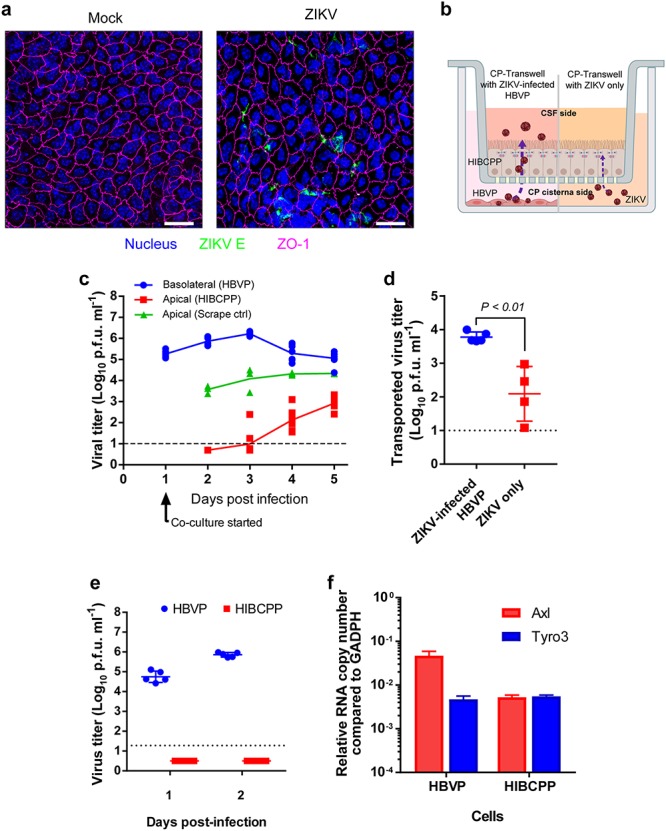
ZIKV crosses CP epithelial cell barriers.a, CPs isolated from ZIKV-infected mice were subjected to immunostaining in a whole-mount choroid plexus assay with antibodies against ZO-1 and ZIKV-E. The top and stroma cell layer was imaged with a Zeiss LSM 710 Duo/LIVE 5 confocal microscope along the Z-axis, and the maximum Z-project image was created with Imaris software. b, HIBCPP Transwell model. HIBCPP cells were grown and differentiated into a monolayer in Transwell inserts. Fully developed HIBCPP Transwell inserts (determined by TEER) were placed in wells with various testing conditions (e.g., primary human brain pericytes or conditioned media). c. Fully developed HIBCPP barriers grown in Transwell inserts (n = 3–5 per group) were basolaterally exposed to ZIKV-infected HBVP cells (starting at 1 DPI). As a leakage control, a scratch was made on the HIBCPP cells fully grown in Transwell inserts. Samples from the apical and basolateral chambers were harvested every 24 hours, and the virus titers were determined. d, Fully developed HIBCPP barriers grown in Transwell inserts (n = 4–5 per group) were basolaterally exposed to ZIKV-infected HBVP cells (3 d.p.i) or fresh media spiked with ZIKV (1.0 x 105 pfu/well/mL). Twenty-four hours later, the cell supernatant in the apical camber was harvested and the virus amount was enumerated. e, HBVP (blue circles) and HIBCPP (red squares) cells grown on 12-well plates were infected with ZIKV (m.o.i. = 0.1) and then incubated for two days. The virus titers in the supernatants were enumerated with a virus titration assay. f, Expression of Axl and Tyro3 in HBVP and HIBCPP was determined by using realtime q-PCR and normalized to endogenous GAPDH expression.